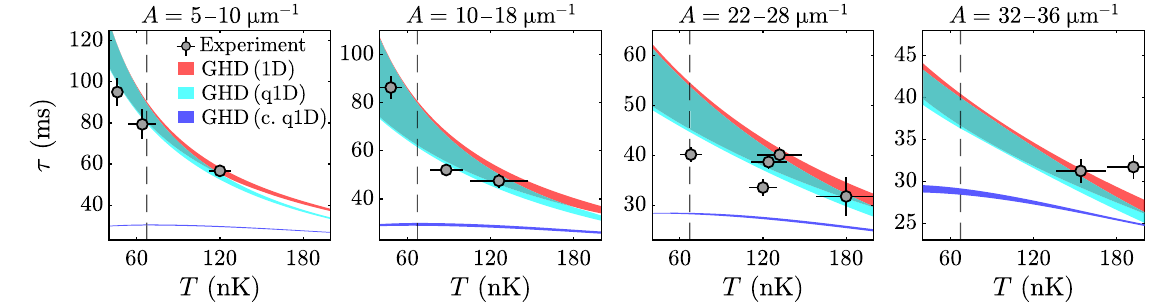
FIG. 5. Relaxation timescale τ of the first density mode. For both experimental measurements (points) and GHD simulations (shaded areas), τ is obtained by fitting the time evolution of the j ¼ 1 density mode δ n 1 ð t Þ with the damped oscillation of Eq. (4). The experimental results are grouped into four ranges of mode amplitudes A . In each plot, τ is shown for different temperatures T . The temperature T is inferred from density ripples analysis, and the corresponding error bars represent the 68% of confidence interval (more details can be found in Ref. [43]). Meanwhile, the error bars on τ represent the 95% confidence interval from the fit to Eq. (4). The T ¼ ℏ ω ⊥ . For each amplitude range, three different GHD simulations are carried out: standard 1D GHD (red), dashed lines mark k B quasi-1D GHD accounting for the fermionic particle statistics (cyan), and quasi-1D GHD with a classical collision integral neglecting the statistics (blue). The GHD results are plotted as shaded areas, whose top and bottom edges mark the smallest and largest mode amplitude within the given range, respectively. All simulations assume a mean atomic density of 75 μ m − 1 , which deviates by up to 20% for some of the measurements. Differences in mean density and effective box lengths between simulation and experiment are accounted for by scaling the experimental time